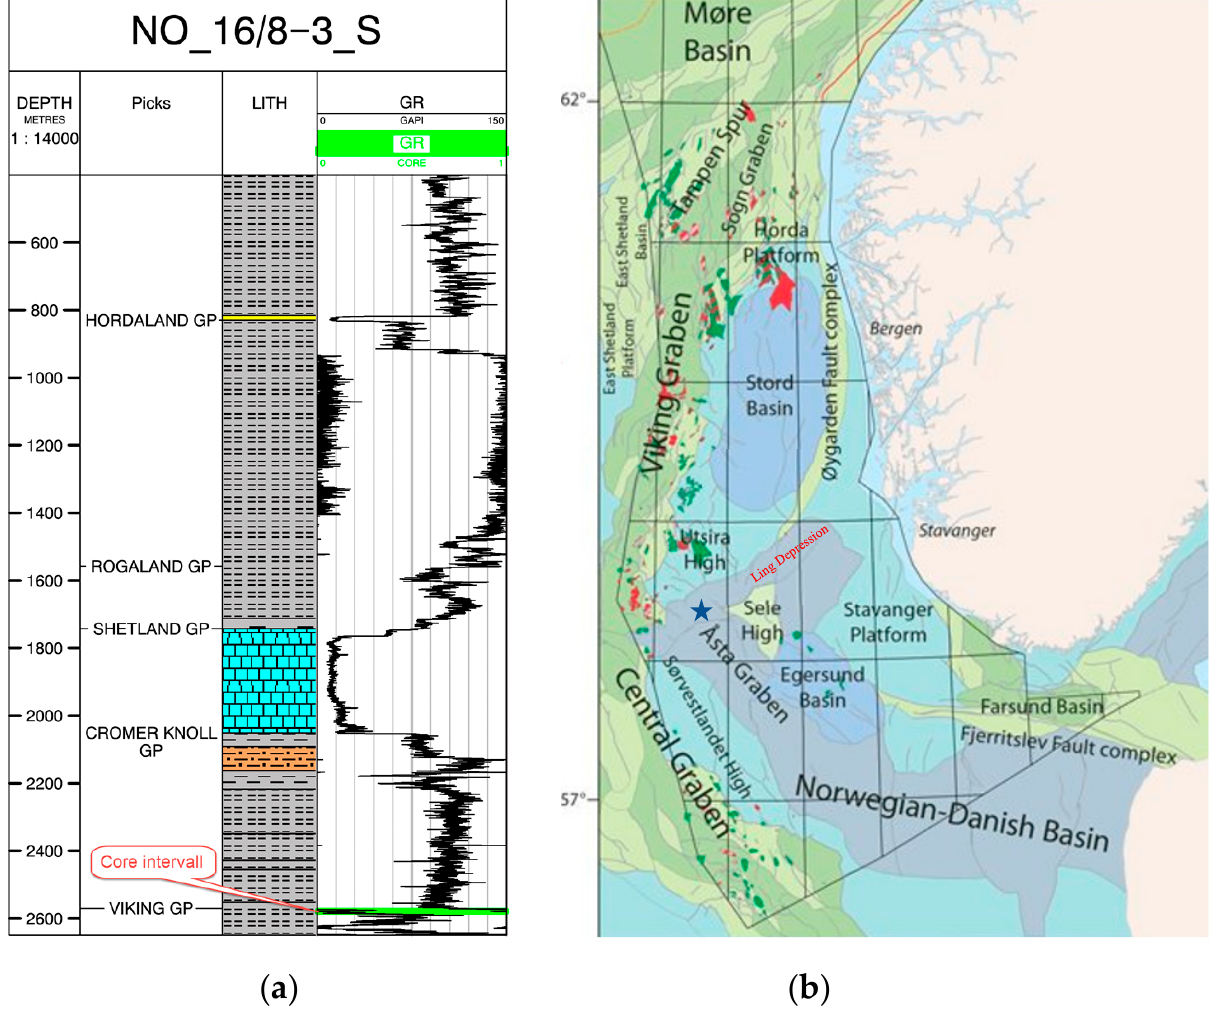
Figure 1. ( a ) The gamma-ray log from well 16/8-3S from where the material used in the current study was sampled from Figure 1 . a ) Gamma ray log from well 16/8-3S from where the material used in the current study Skurtveit et al. [28]. The core interval from the top of the Draupne section is indicated by “core interval” in red. ( b ) Map was sampled from Skurtveit et al. [28]. The core interval from the top of the Draupne section indi- showing the location of the Ling depression in the North Sea and approximate location of well 16/8-3S (blue star). Map cated by "core interval" in red. b ) Map showing the location of the Ling depression in the North Sea modified from the Norwegian Petroleum Directorate and approximate location of well 16/8-3S (blue star). Map modified from the Norwegian Petroleum Directorate [38].